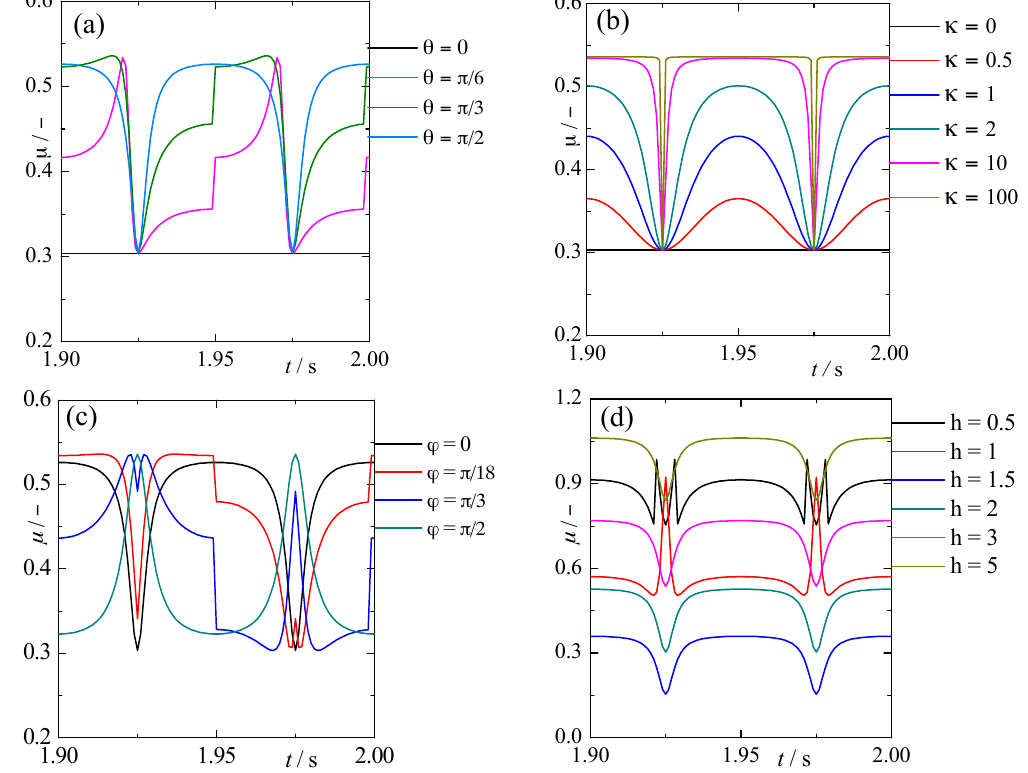
Figure 10. The effect of main parameters on frictional coefficient. ( a ) Vibration direction angle θ ; ( b ) velocity ratio κ ; ( c ) orientation angle of single contact patch ϕ ; ( d ) height of single contact patch h .